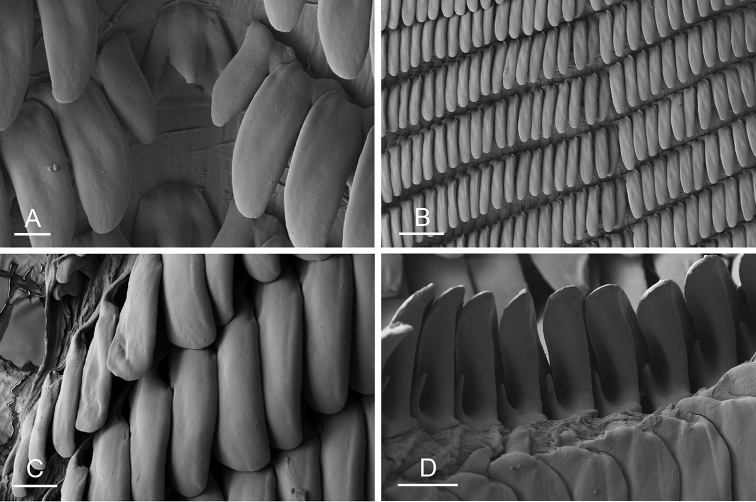
Radula, Peronia
verruculata (unit #5), Madagascar A–C [3231] (MNHN-IM-2019-1610) D Mozambique [5510] (MNHN-IM-2013-62398) A rachidian and innermost lateral teeth B lateral teeth C outermost lateral teeth D lateral teeth, frontal view. Scale bars: 20 μm (A, C), 100 μm (B), 30 μm (D).